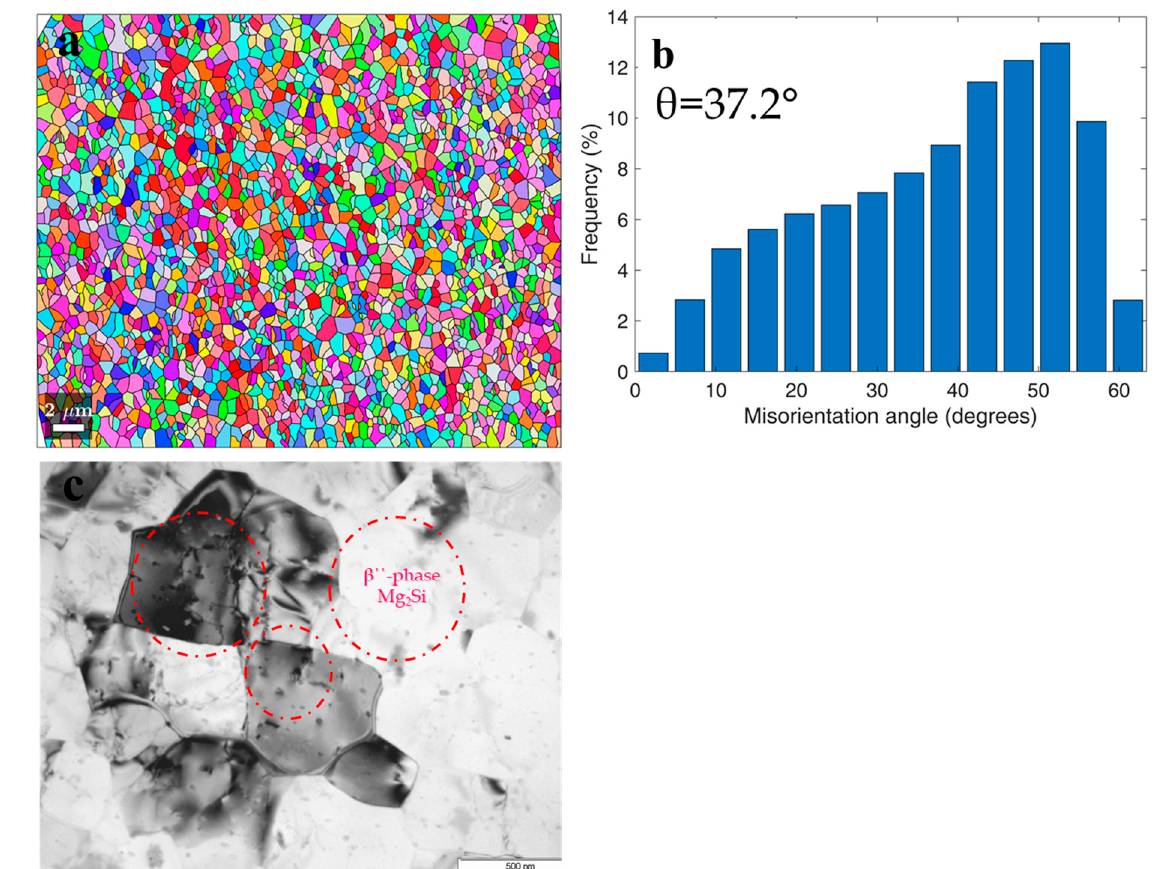
Figure 2. The microstructure of the UFG 6060 alloy produced by HPT ( a ) orientation map (transverse direction); ( b ) grain boundary misorientation distribution; ( c ) bright field TEM image revealing nanoscale precipitates and dislocations.